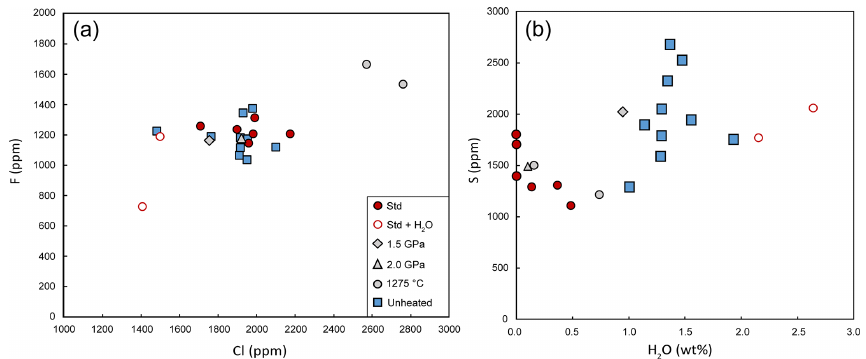
Figure 7. (a) Fluorine (ppm) as a function of chlorine (ppm) in melt inclusion glasses. (b) Sulfur (ppm) vs. H 2 O (wt%) in melt inclusion glasses. Melt inclusions contaminated by NaCl during homogenization experiments are not shown because of their high Cl contents (more than 3wt%). Symbols are as follows: solid blue squares, unheated melt inclusions; red circles, homogenization experiments at 2.5GPa– 1300 ◦ C without water (solid red circles) or with added water (empty red circles); solid grey diamond, experiment at 1.5GPa–1300 ◦ C; solid grey triangles, experiment at 2GPa–1300 ◦ C; and solid grey circles, experiment at 2.5GPa–1275 ◦ C. The data are corrected for PEC/PED.